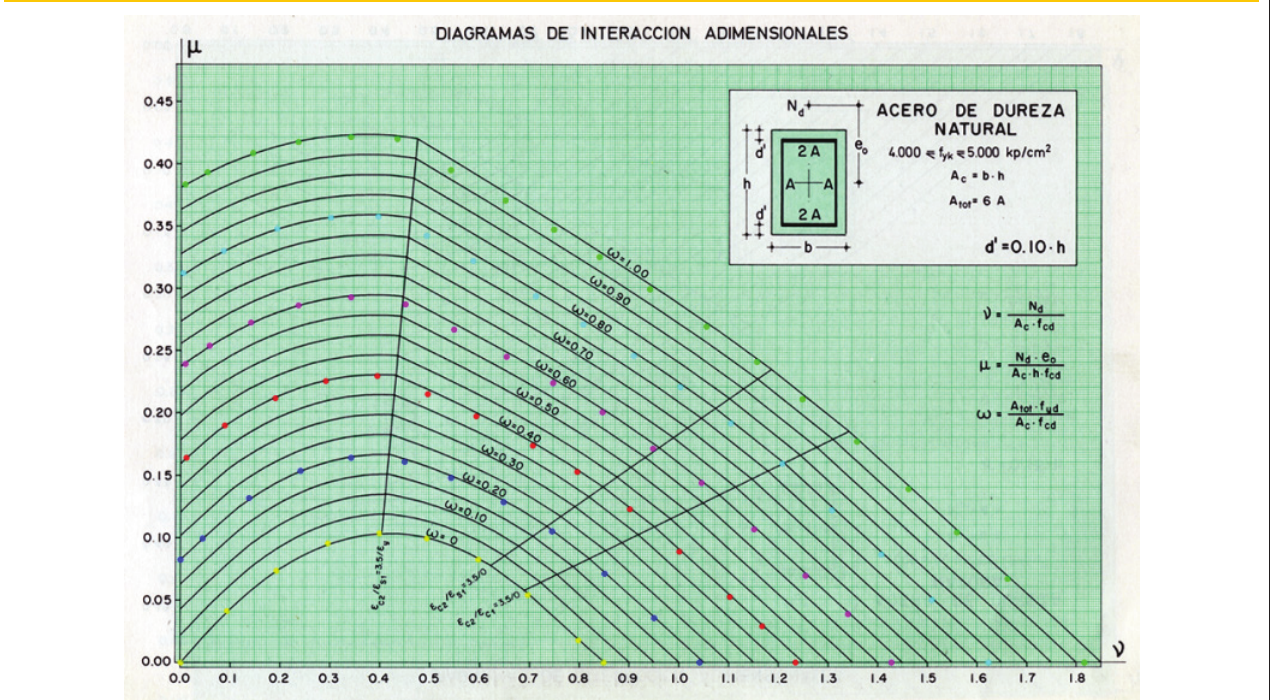
Figure 9 – Comparison of results with interaction diagrams for uniaxial bending (Montoya et al.